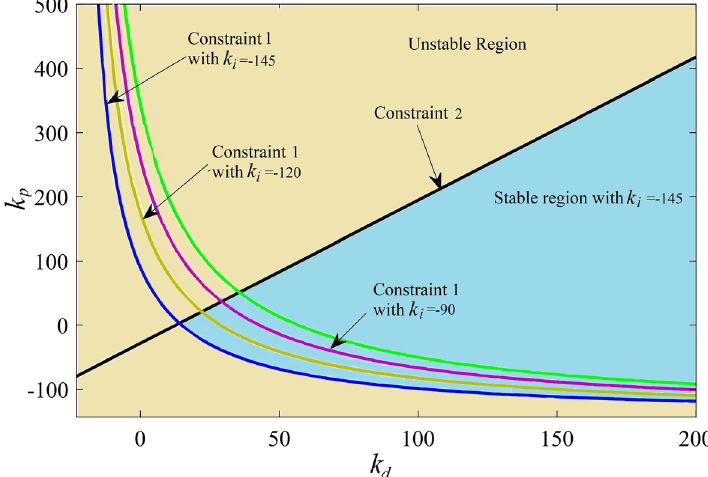
Fig. 8 Stable and unstable regions in the k d -k p plane with a fixed k i for an interval polynomial using proposed stability conditions